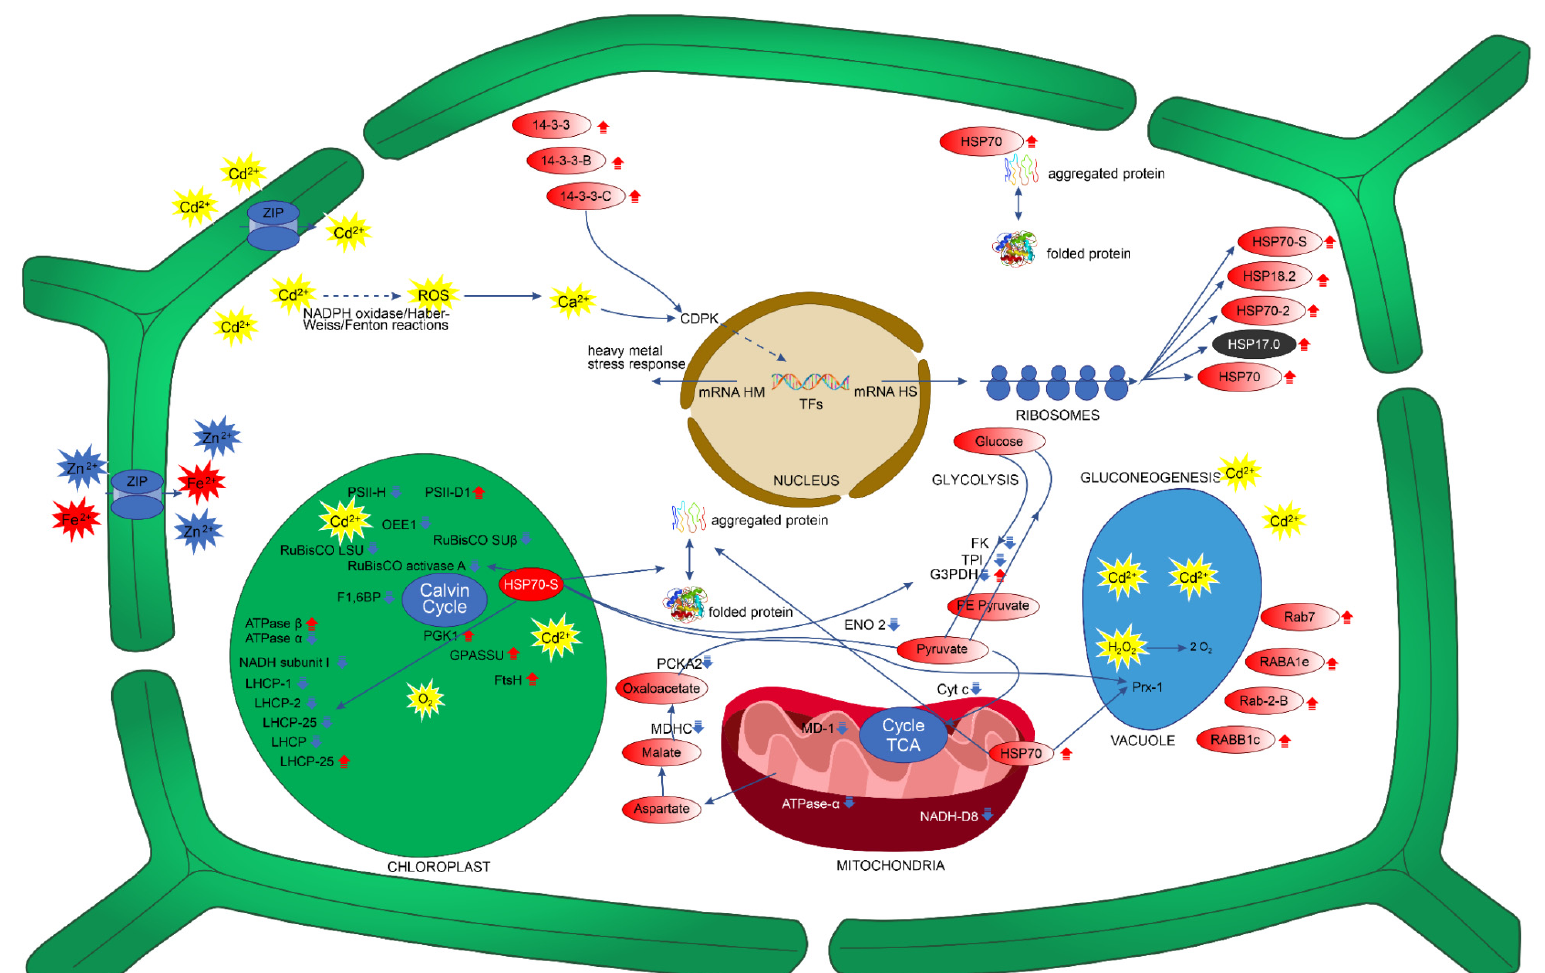
Figure 2. Possible mechanisms of tolerance in response to Cd stress based on changes in the proteome in P. fasciculatum leaves after 60 days. RuBisCO LSU: ribulose bisphosphate carboxylase large chain; RuBisCO SU β : RuBisCO large subunit-binding protein subunit beta; RuBisCO activase A: ribulose bisphosphate